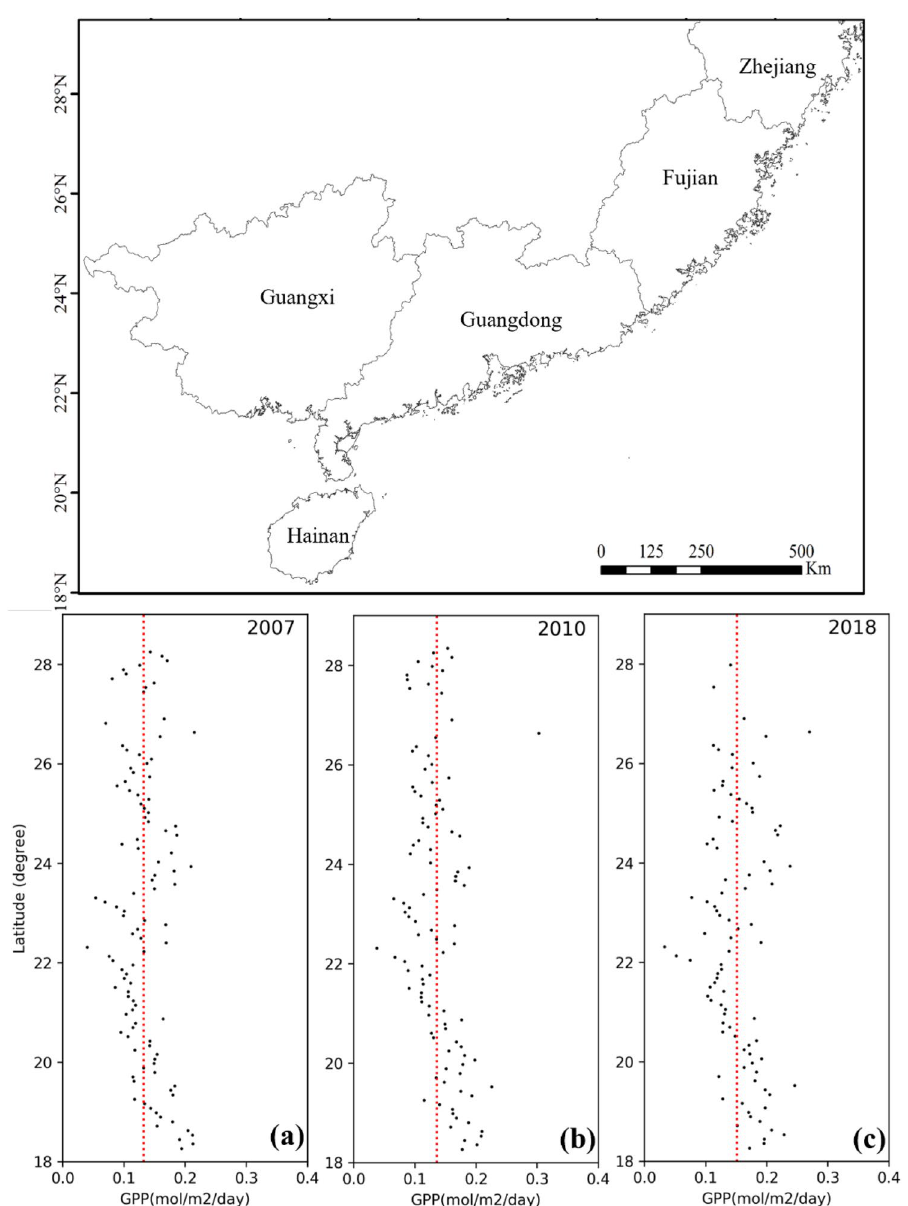
Figure 7. Spatiotemporal distributions of GPP in mangrove forests over China: ( a ) 2007, ( b ) 2010, and ( c )